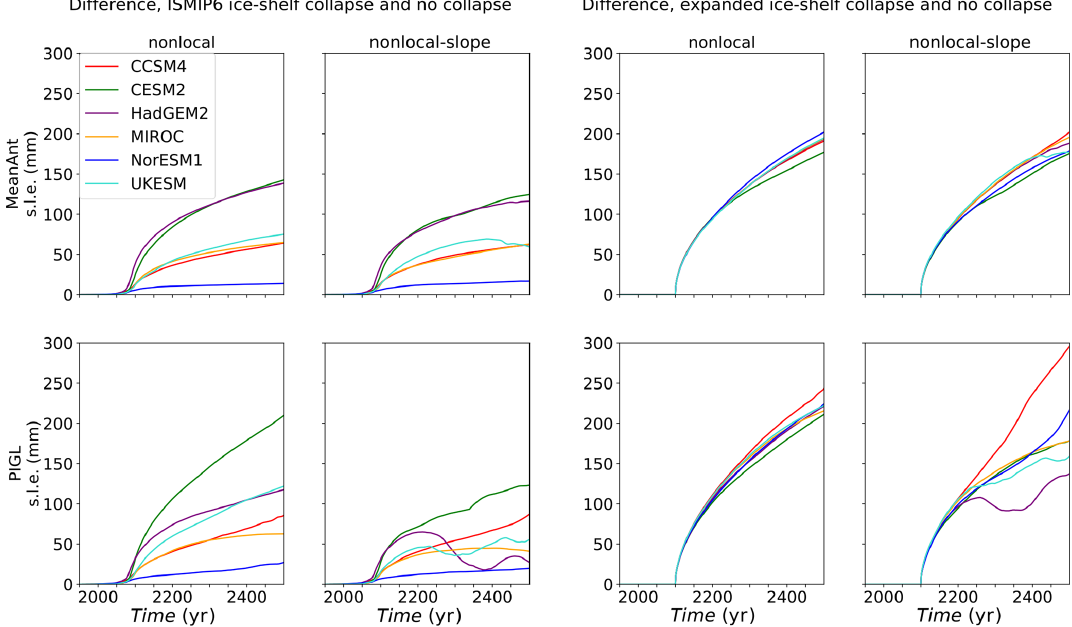
Figure 17. Difference in SLR contribution (mms.l.e.) during 550-year projection experiments, comparing runs with and without ice-shelf collapse. The four left-hand panels show differences between runs with shelf collapse prescribed by ISMIP6 (Nowicki et al., 2020) and runs without collapse (standard experiments). The four right-hand panels show differences between runs with prescribed collapse of most ice shelves (excluding Ross, Filchner–Ronne, and Amery) in the year 2100 and runs without collapse. Positive values indicate a greater SLR contribution in runs with collapse. The four panels for each collapse pattern correspond to the nonlocal and nonlocal-slope melt parameteri- zations with the MeanAnt and PIGL calibrations.